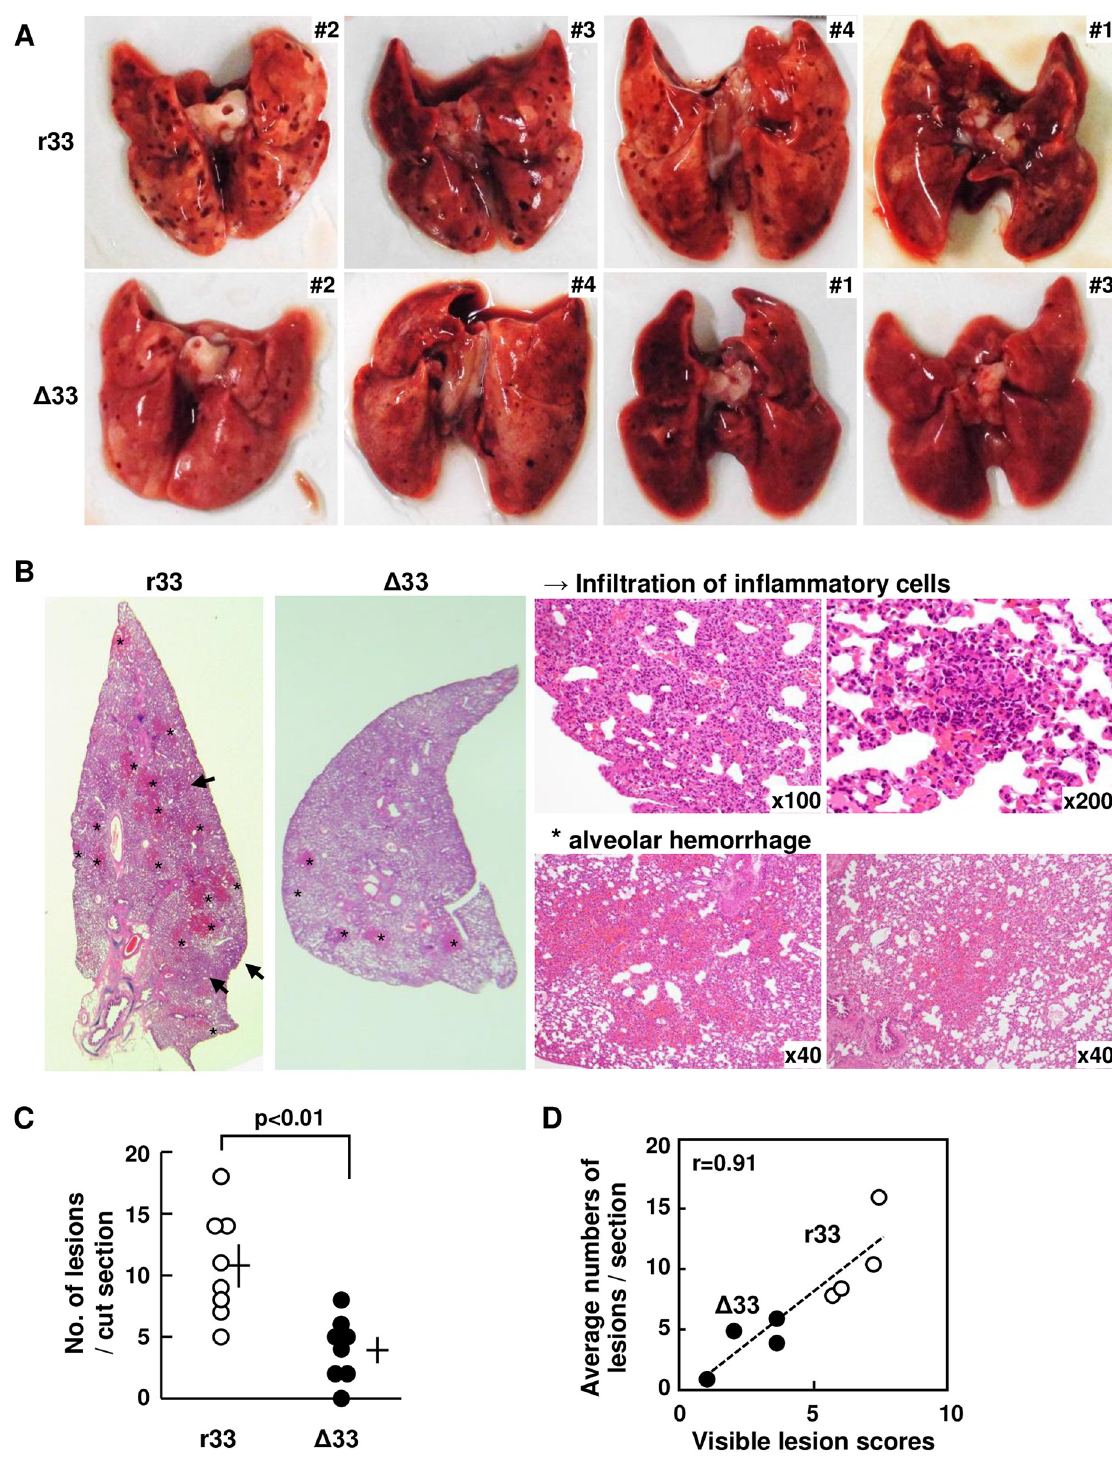
Fig 9. Pathological findings in r33- and Δ 33-infected dams at 3 weeks p.i. (A) Images of the lungs obtained from the dams infected with r33 (upper row) or Δ 33 (lower row), which are described in the legend for Fig 8, are shown in the order of abnormalities in appearance